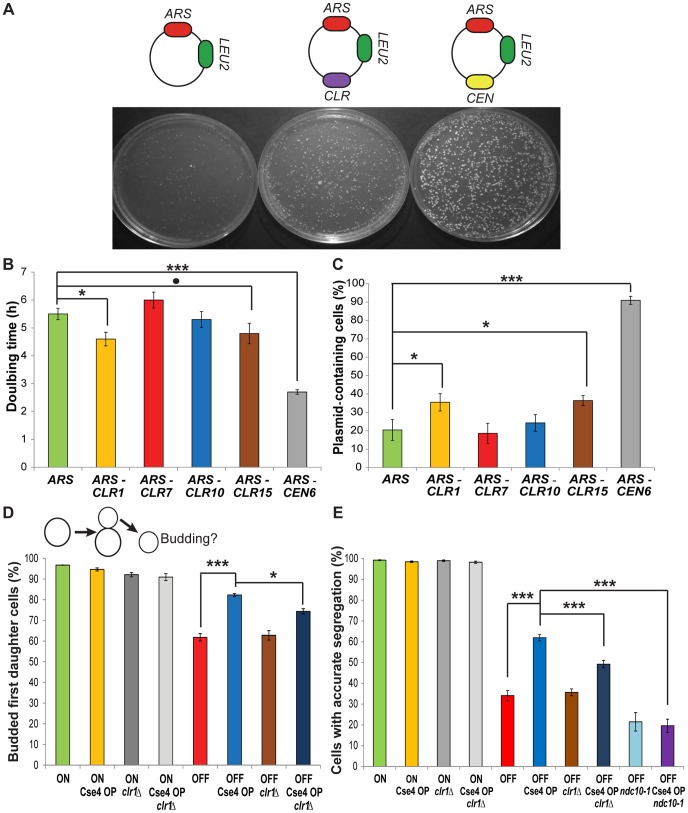

CLRs confer centromere function on plasmids and chromosomes.(A) Top: Representation of ARS, CLR and CEN plasmids. Bottom: Transformation plates from strains carrying different plasmids. (B) Doubling times in selective medium of strains carrying different plasmids (Means+/−SEM). (C) Fraction of plasmid-containing cells after growth in non-selective media for strains bearing various plasmids (Means+/−SEM). P-values were computed using MCMC simulations (* p<0.05, ** p<0.01, *** p<0.001,. p = 0.07) (B–C). (D) Top: Depiction of pedigree assay. Unbudded mother cells contain a conditional CEN3 (ON raffinose; OFF galactose) or not (ON raffinose or galactose). Bottom: Fraction of budded daughter cells 12 h after transfer of mother cells to plates containing galactose (Means+/−SEM). ON and OFF indicate the presence of conditional CEN3. For the four left-most bars, similar values were obtained for strains with conditional CEN3 grown in raffinose (ON). A time course is shown in Figure S4. (E) Fraction of cells that segregated properly their GFP-labelled chromosome 3, as visualized by the presence of a GFP dot in each cell (Means+/−SEM). P-values have been calculated using Fisher's Exact Test (* p<0.05, ** p<0.01, *** p<0.001) (D–E).